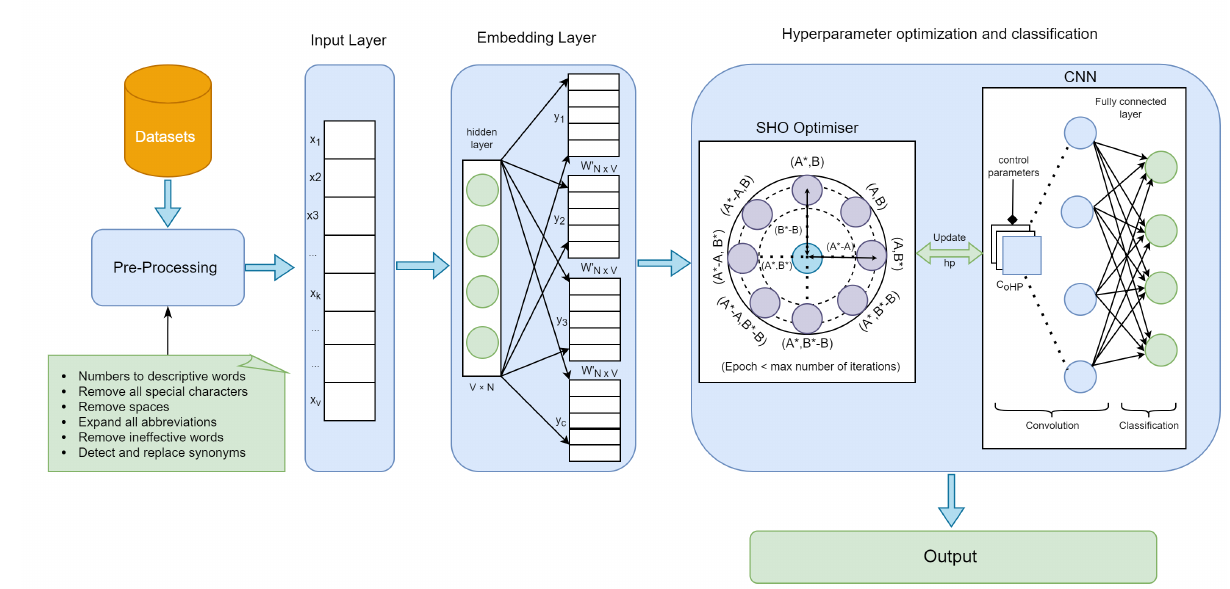
Figure 1. Architecture of the proposed SHO-CNN for MLTC of